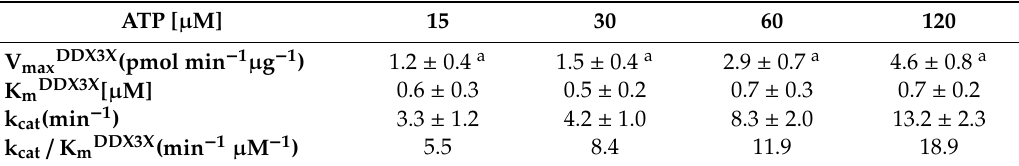
Table 5. Kinetic parameter values of CK1 ε as a function of varying DDX3X concentrations at fixed ATP